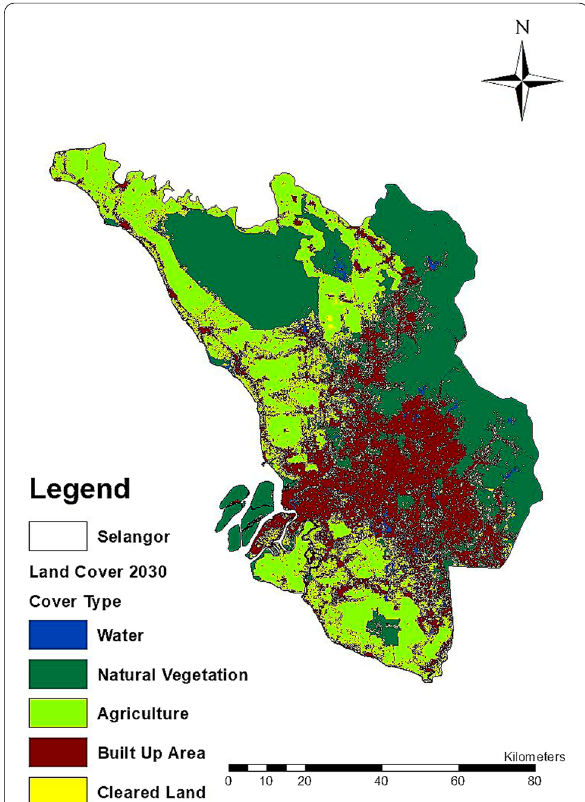
Fig. 8 The quantity and allocation disagreement showcasing the validation of the simulated map with the reference